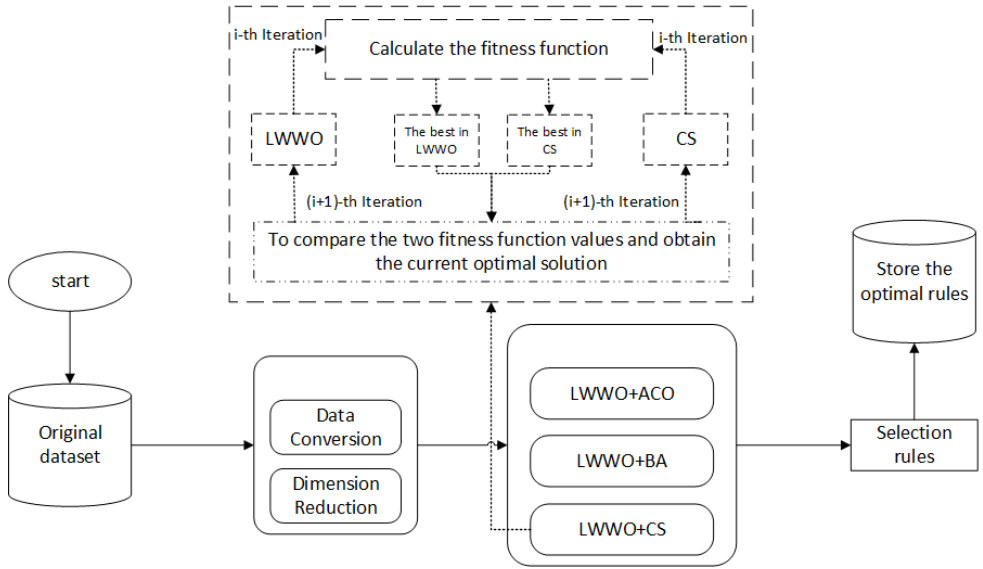
Figure 1. The overall model of the hybrid algorithm for ARM.